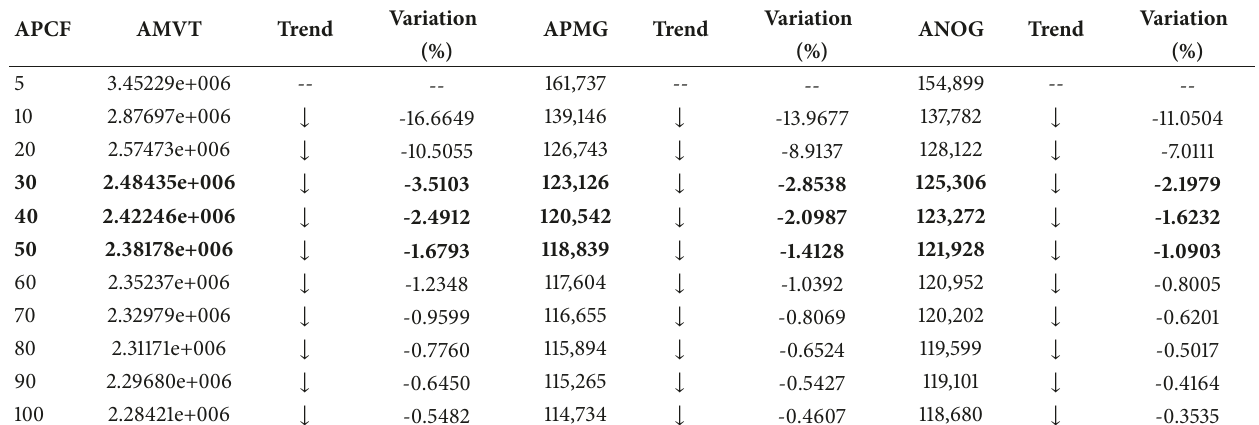
Table 8: The effects of different APCFs on AMVT, APNG, and ANOG.